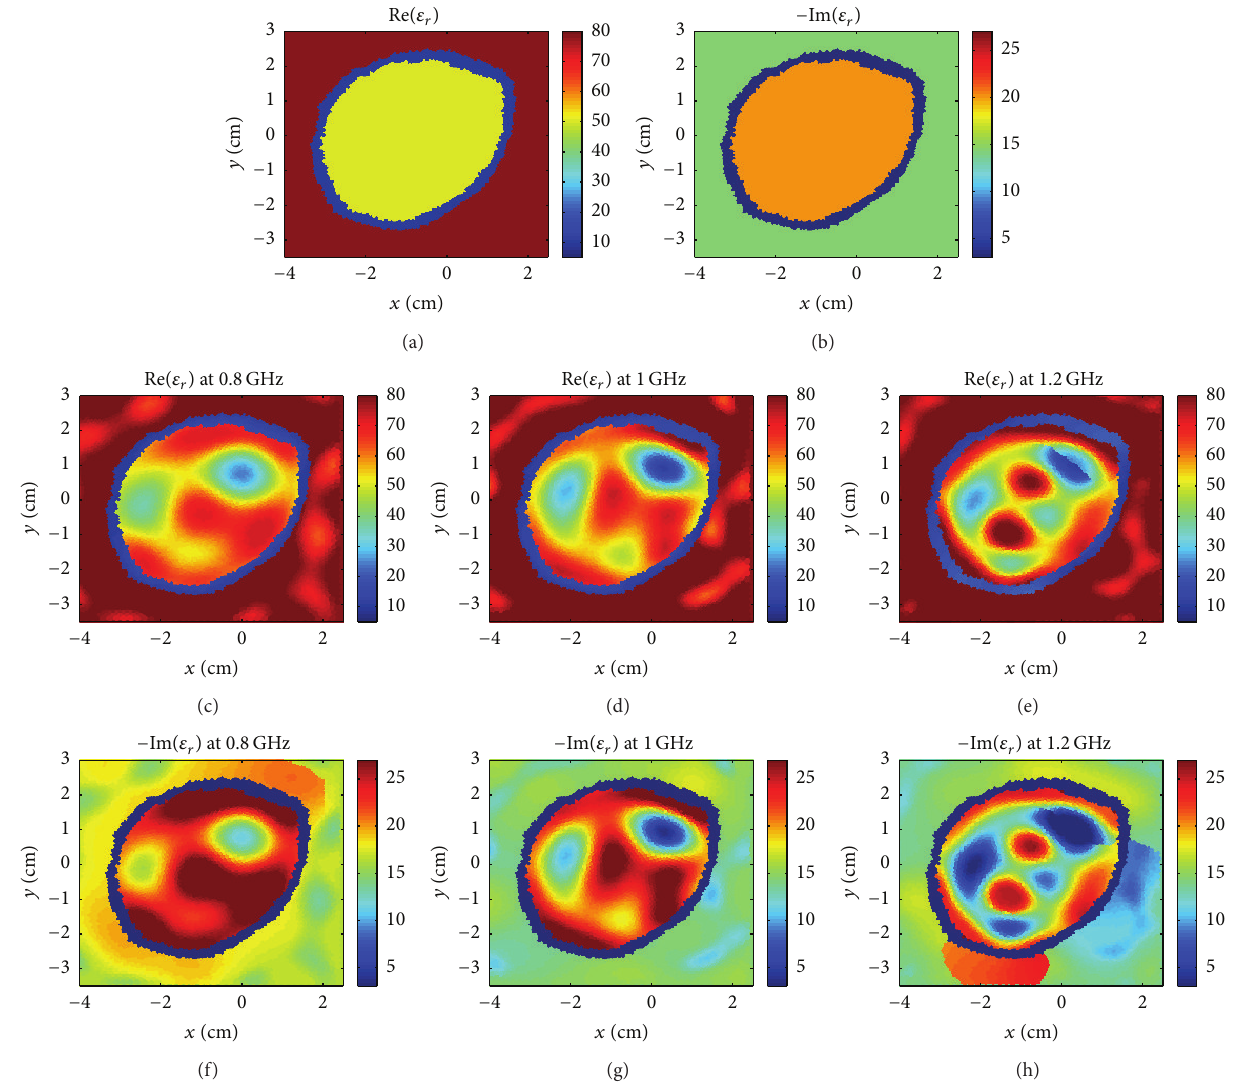
Figure 14: Volunteer 5: (a)-(b) prior information. The reconstruction when prior information is used as inhomogeneous background at (c), (f) 0.8 GHz, (d), (g) 1GHz, and (e), (h) 1.2GHz.